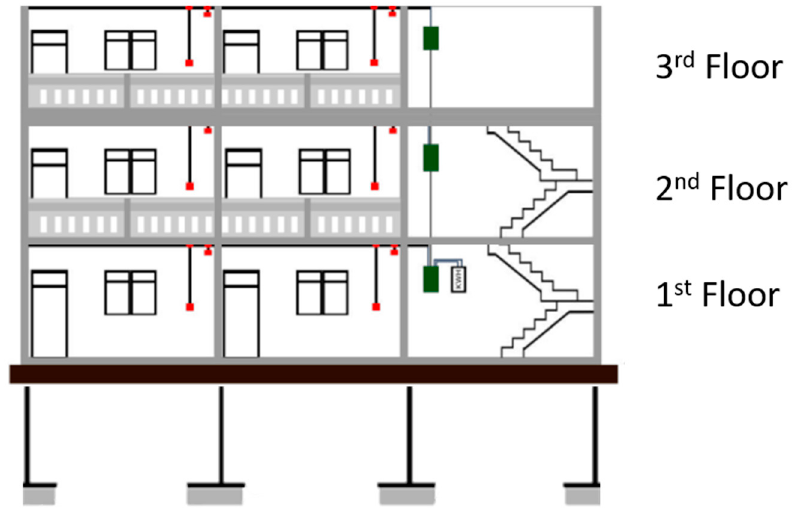
Figure 16. A 3-story steel building model [179]. Figure 16. A 3 ‐ story steel building model [179]. Figure 16. A 3 ‐ story steel building model [179].